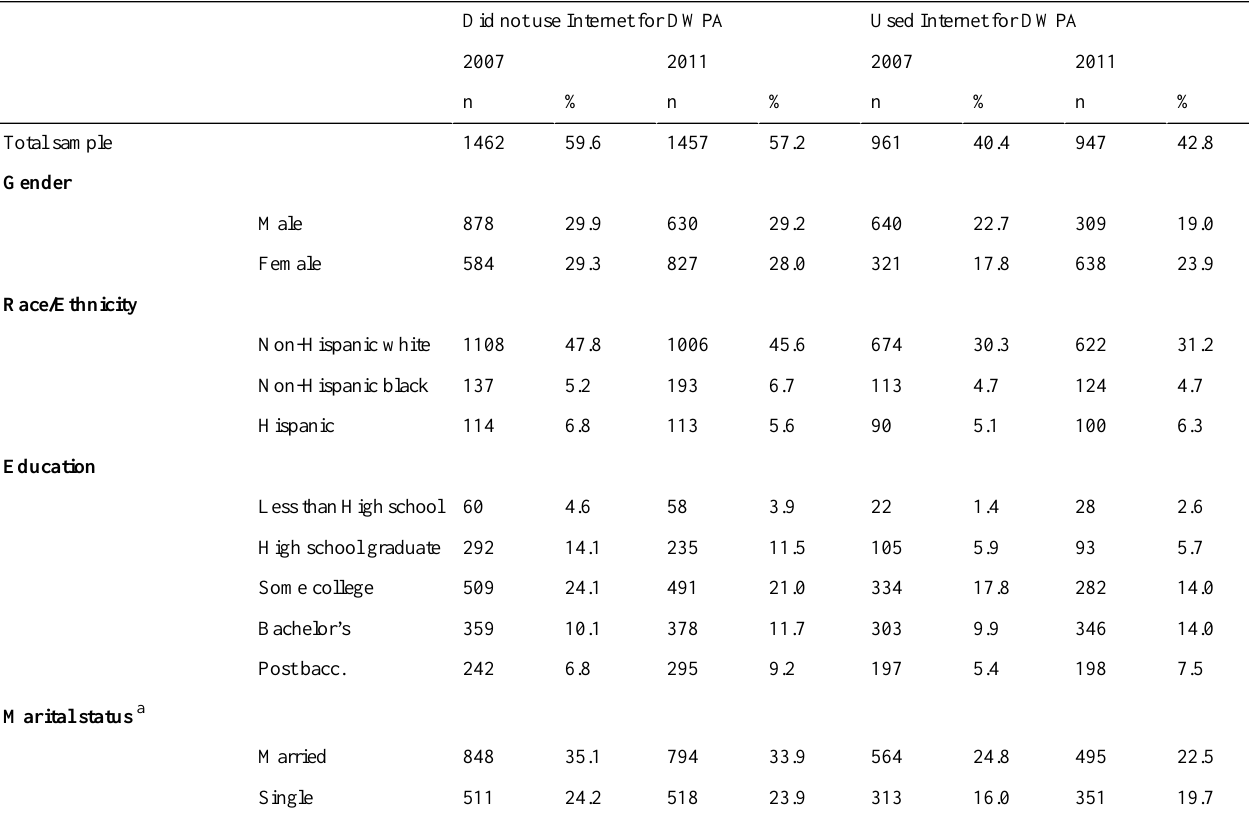
Table 1. Demographic correlates of using the Internet for help with DWPA in 2007 and 2011.